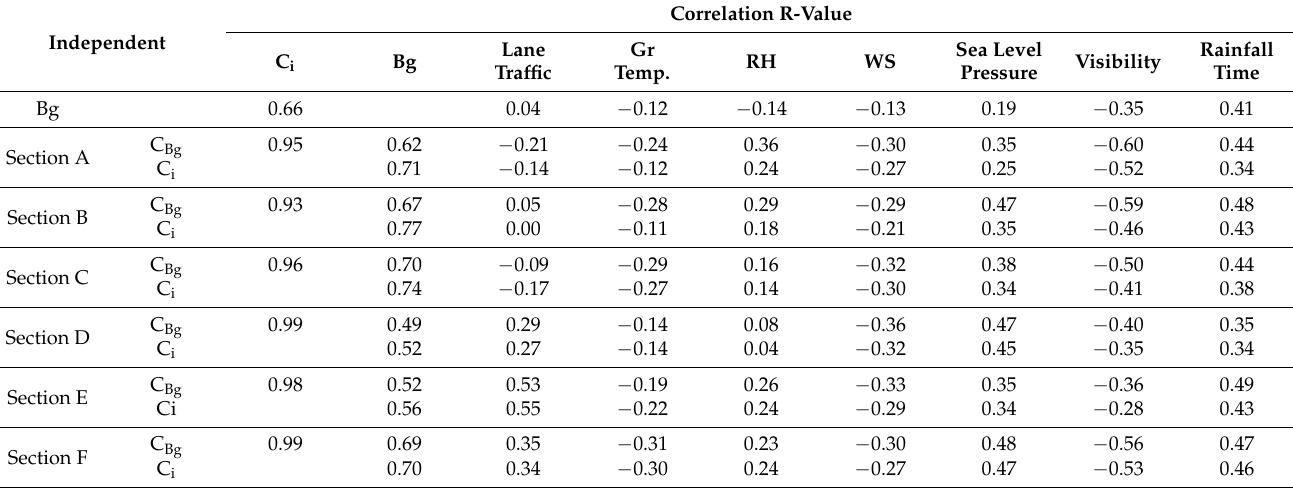
Table 5. Bg, C Bg, C i by interval and correlation analysis of major